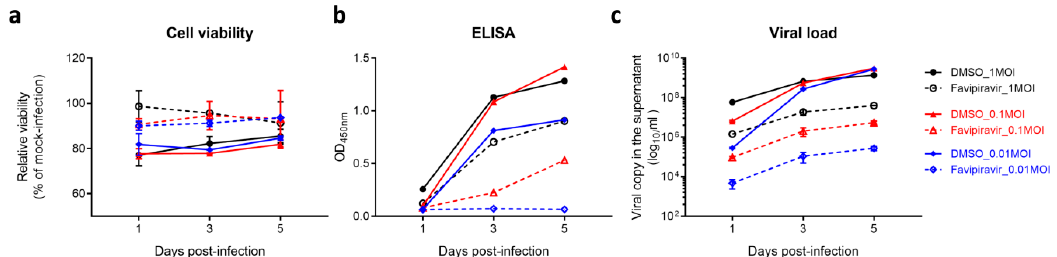
Figure 1. Optimization and comparison of biochemical assays for Food and Drug Administration- (FDA) approved drug compound library screening. Vero cells seeded in 96-well plate were infected with severe fever with thrombocytopenia syndrome virus (SFTSV) for 1 h with the multiplicities of infection (MOIs) indicated (1, 0.1 and 0.01), followed by phosphate bu ff ered saline (PBS) wash and replacement of fresh Dulbecco’s modified eagle medium (DMEM) containing 0.1% DMSO (negative control) or favipiravir (50 µ g / mL, positive control). ( a ) Cell viability of each well was determined on day 1, 3, and 5 post-infection, which was normalized by that of the mock-infected cells. ( b ) Cell culture supernatant was collected at the indicated time points and applied for ELISA to measure the SFTSV- nucleoprotein (NP) protein intensity. ( c ) Alternatively, viral copy in the supernatant was determined by quantitative RT-PCR (qRT-PCR). The experiments were carried out in triplicate. The results are shown as mean ± standard deviation.